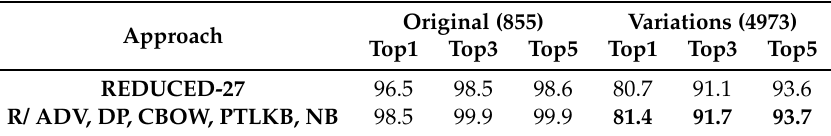
Table 11. Proportion of original questions and variations correctly matched with original FAQs (Top1), in Top-3 and in Top-5 most similar, using the most promising STS models only on the Top-30 most relevant questions, according to